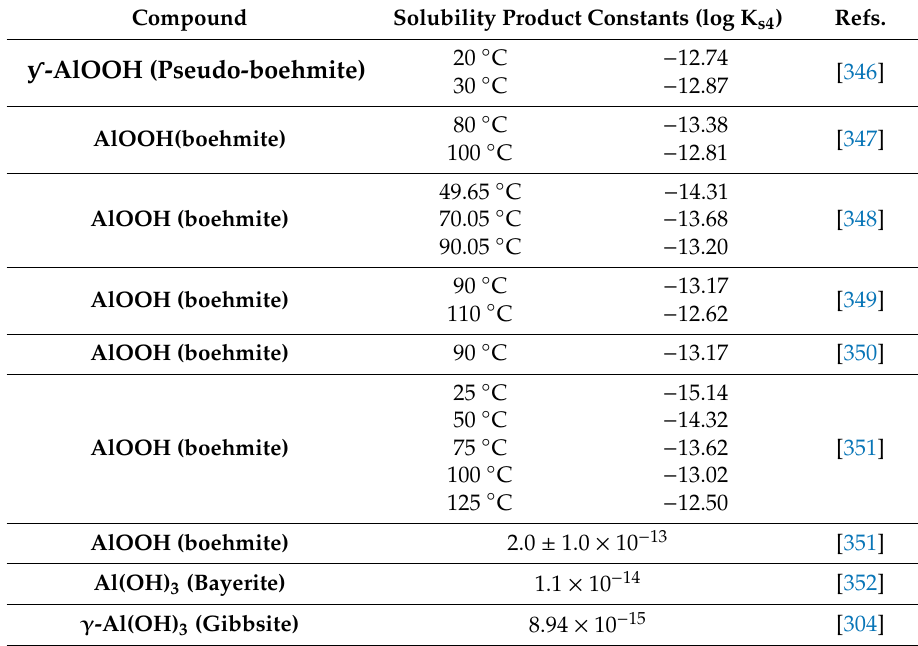
Table 5. Solubility data of aluminum compounds relevant to the sealing process.